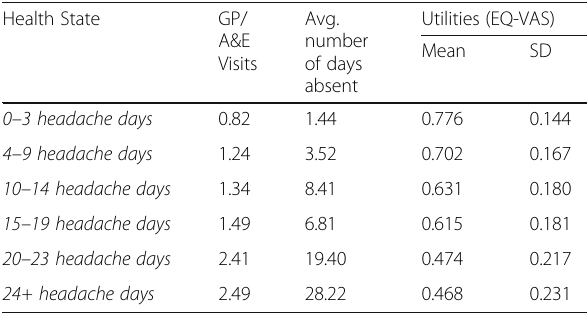
Table 5 Resource use, utilities and work loss per 3-month period by number of headache days per month Health